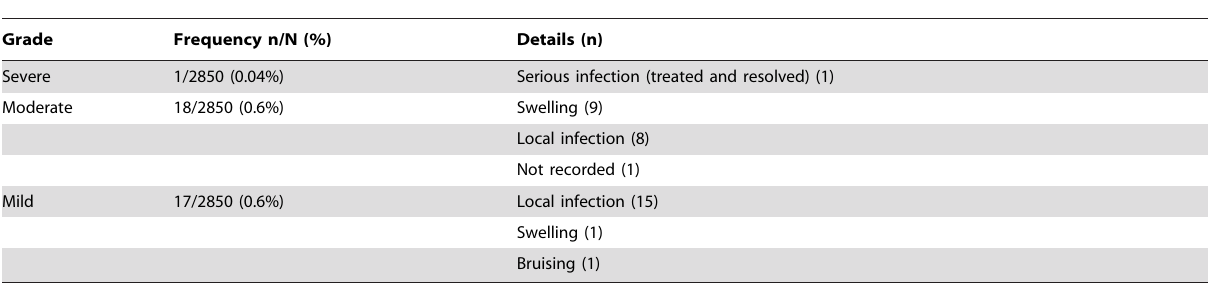
Table 1. Adverse Effects March 2012-February